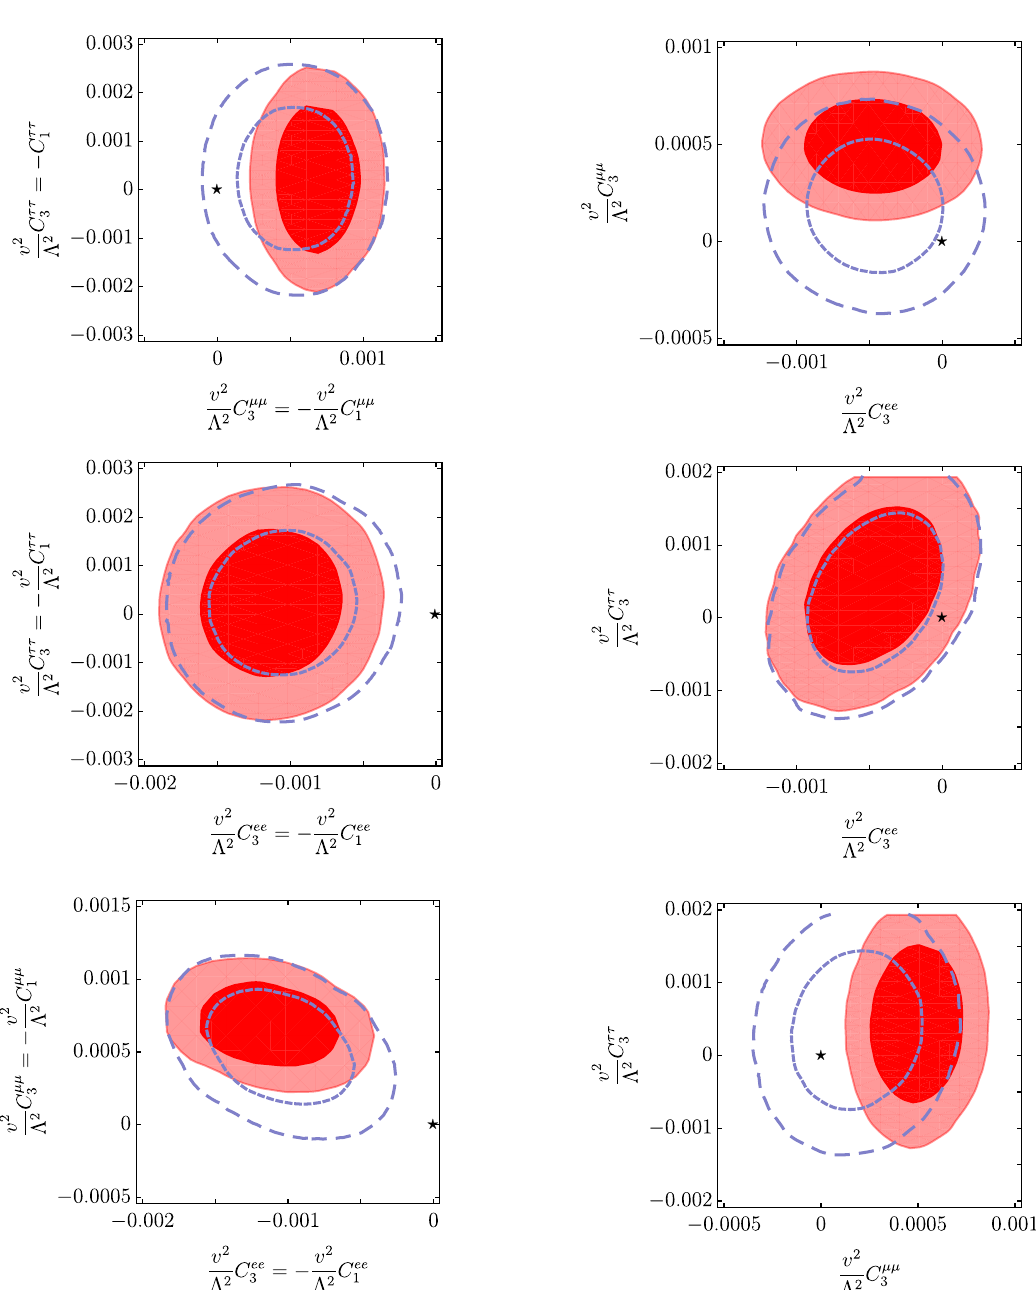
Figure 4 . Global fit for the 3-dimensional scenarios C (1) in figure 3, the dashed lines indicate the effect of include the additional NNCs, the star indicates the SM point, and the regions correspond to 68% and 95%